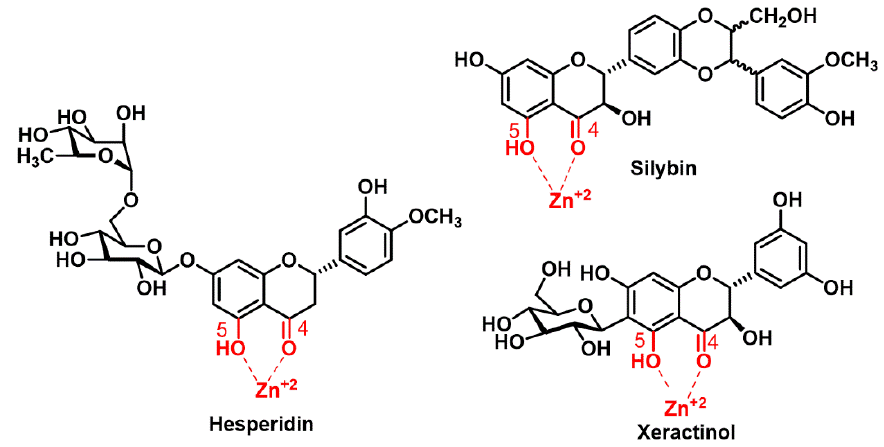
Figure 10. Intramolecular hydrogen bonds between the oxygenated functions of the polyphenols silybin, hesperidin and xeractinol in combination with the zinc cation.